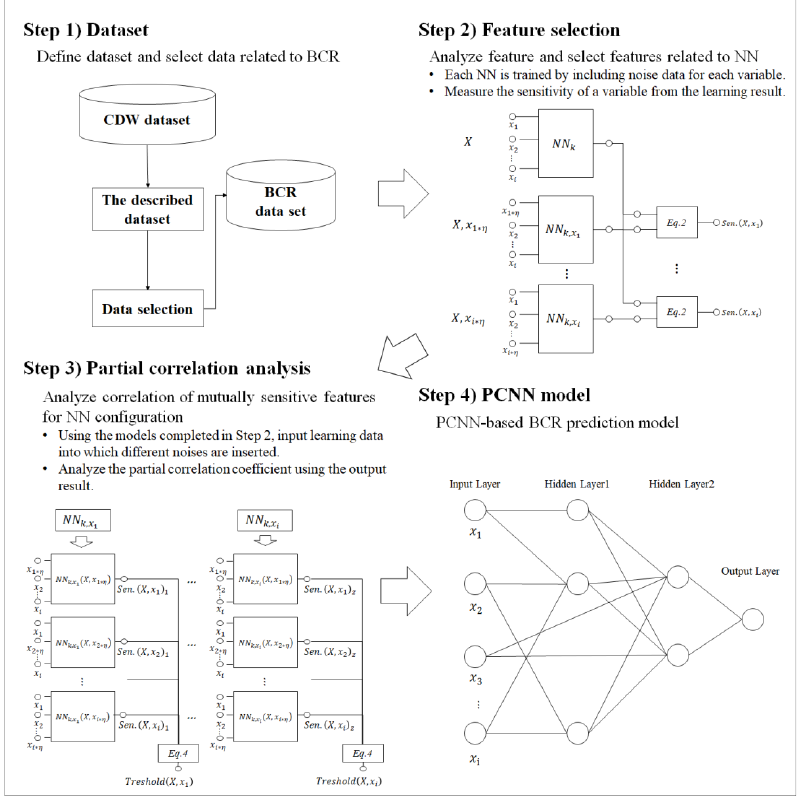
Figure 1. Study design. CDW, Clinical Data Warehouse ; BCR, biochemical recurrence; NN, neural network; PCNN, partial correlation neural network.